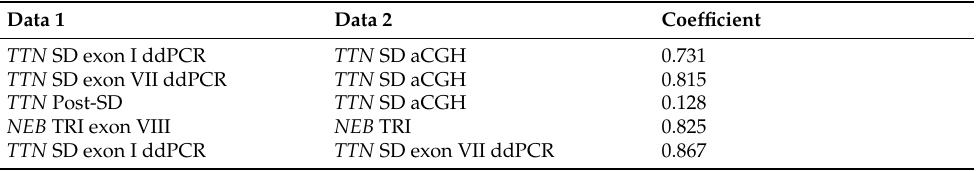
Table 2. Pearson correlation coefficients for interpreted CN by ddPCR against NMD-CGH array derived CN estimates. A Pearson correlation coefficient of 0.70 was considered the lower threshold for a strong